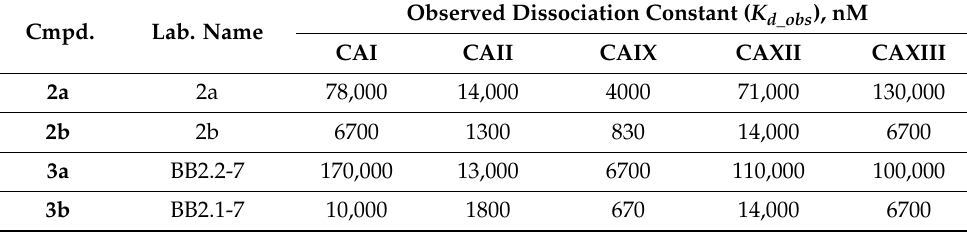
Table 1. The observed dissociation constants of CAI, CAII, CAIX, CAXII, and CAXIII with tested compounds at pH 7.0 and 37 ◦ C by the fluorescent thermal shift assay. ND– K d_obs value was not determined. K d_obs data of compounds 21 [30] , 26 [31] , and 35 [31] were taken from previous publica- tions, as well as compound laboratory names marked with *. The standard deviation of the FTSA measurements is ± 1.6-fold in K d_obs